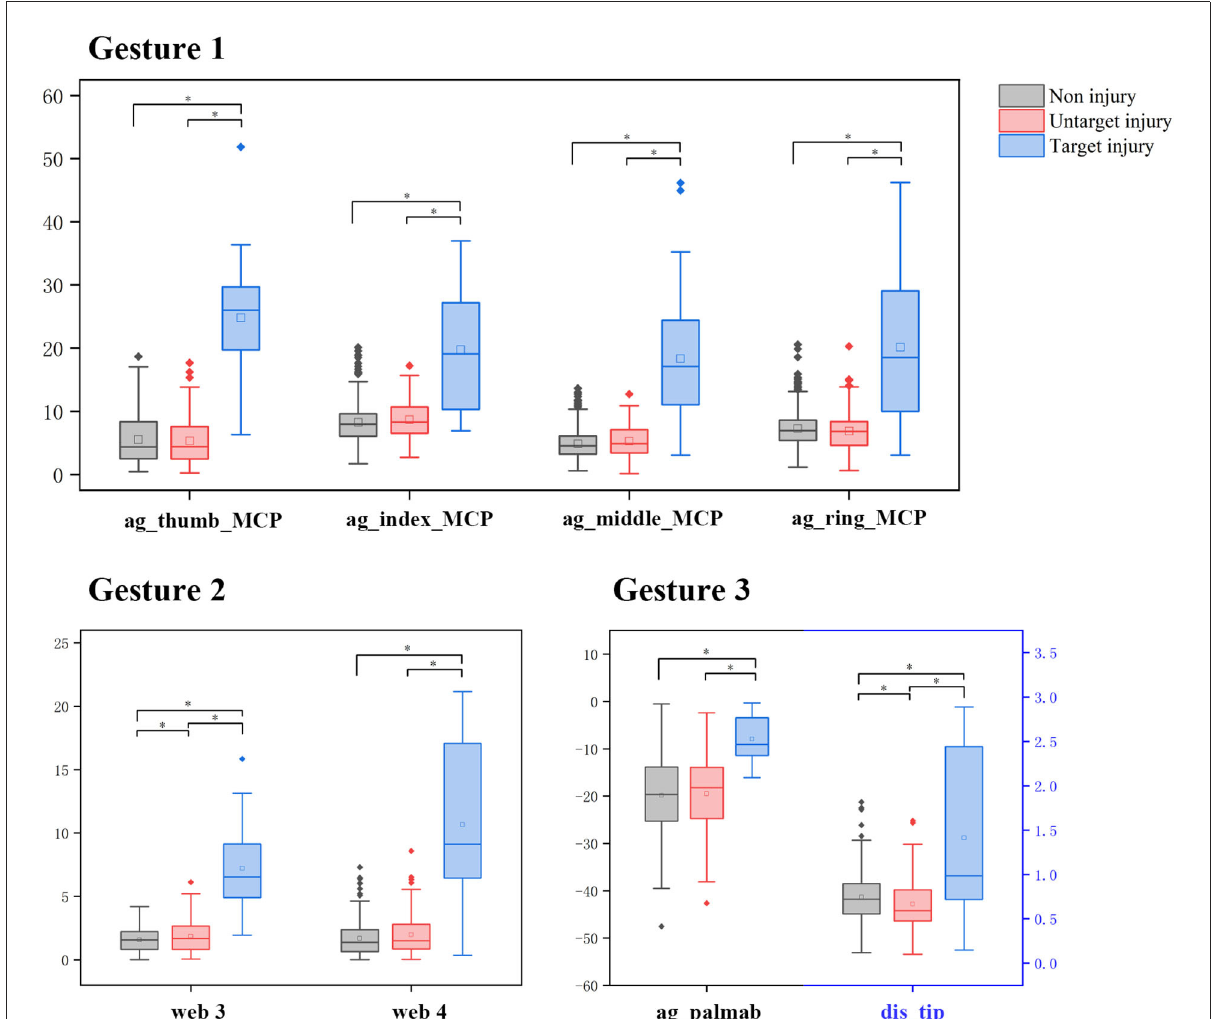
FIGURE4 The subgroup analysis of features after selection. *Represents a significant difference among the hands with non-injury, untargeted injury, or targeted injury of all selected features ( P < 0.05, independent t